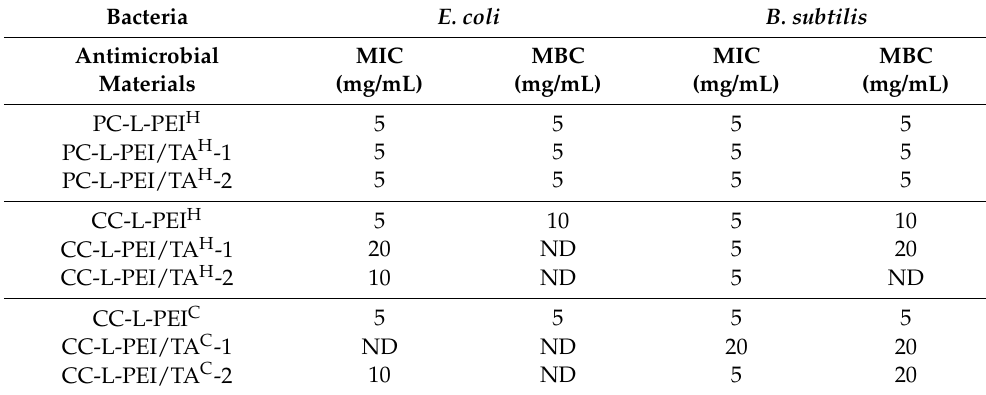
Table 3. Minimum inhibition concentration (MIC) and minimum bactericidal concentration (MBC) values of L-PEI-based materials against E. coli and B. subtilis strains. Bacteria E. coli B. subtilis Antimicrobial MIC MBC MIC MBC Materials (mg/mL) (mg/mL) (mg/mL) (mg/mL) PC-L-PEI H 5 5 5 5 PC-L-PEI/TA H -1 5 5 5 5 PC-L-PEI/TA H -2 5 5 5 5 CC-L-PEI H 5 10 5 10 CC-L-PEI/TA H -1 20 ND 5 20 CC-L-PEI/TA H -2 10 ND 5 ND CC-L-PEI C 5 5 5 5 CC-L-PEI/TA C -1 ND ND 20 20 CC-L-PEI/TA C -2 10 ND